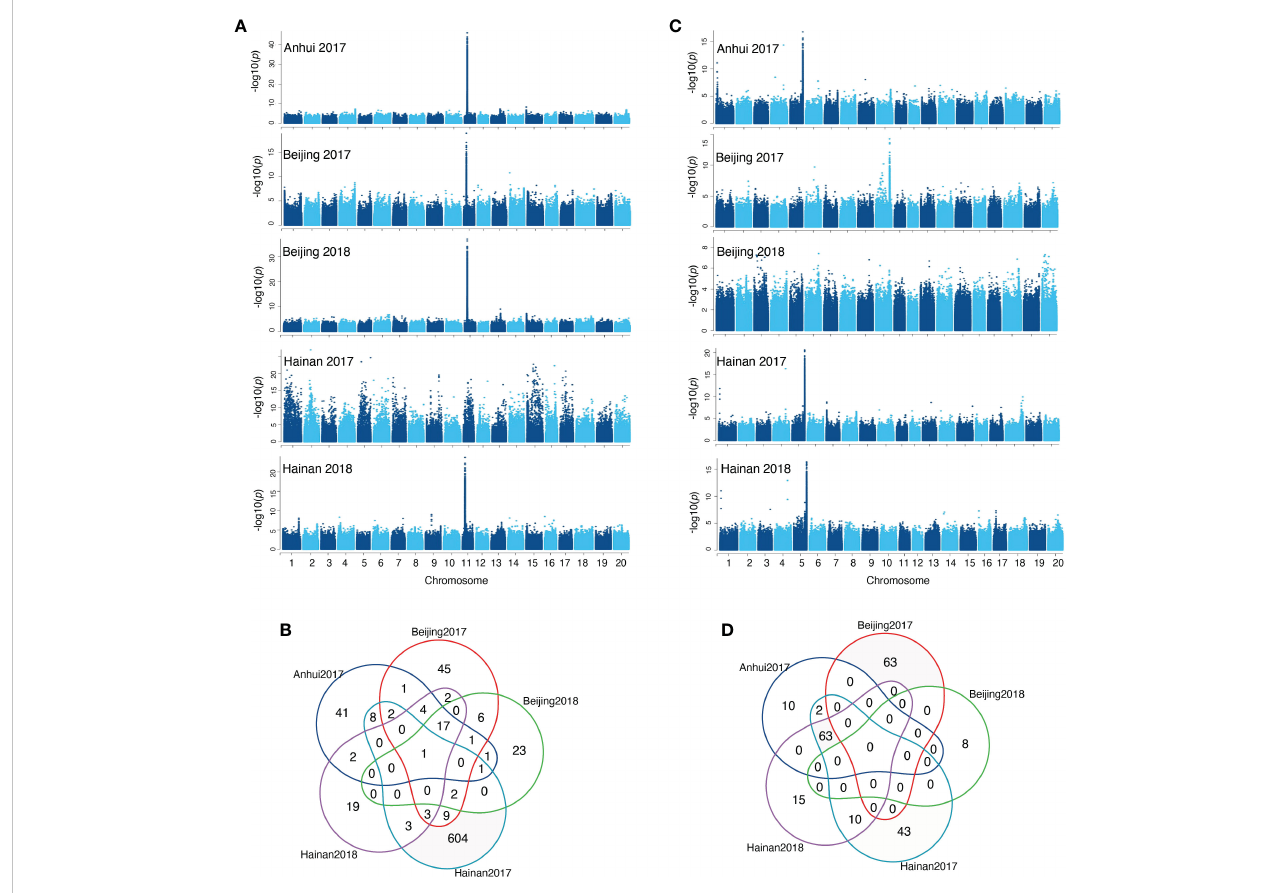
FIGURE 3 (A) Manhattan plots of malonylglycitin for fi ve environments, (B) Venn plot for malonylglycitin genes in fi ve environments, (C) Manhattan plots of TIF content for fi ve environments, (D) Venn plot for TIF content genes in fi ve